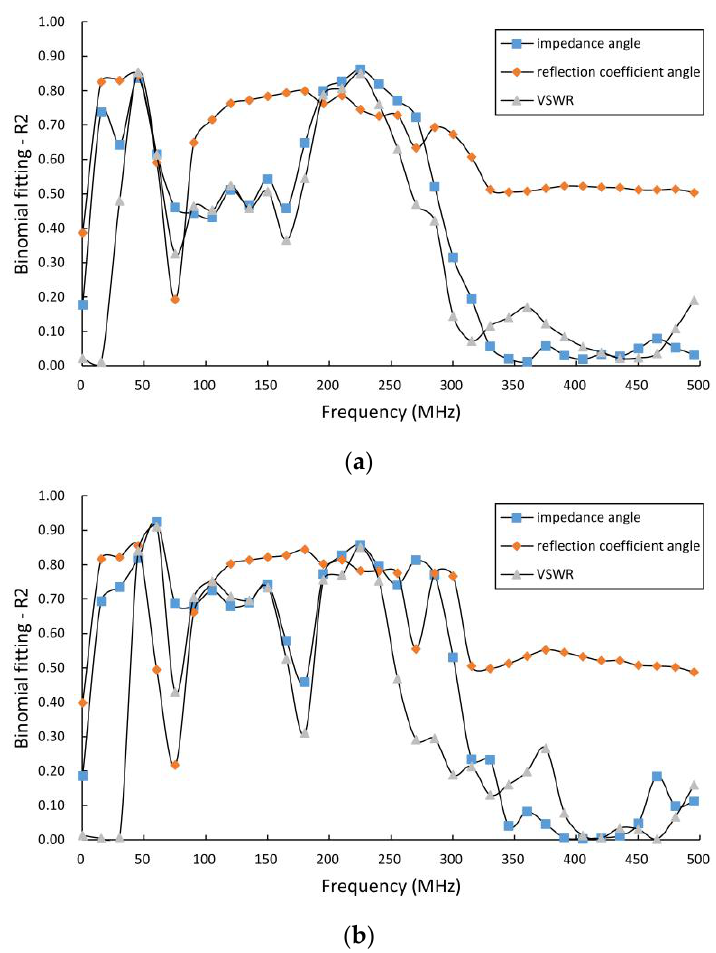
Figure 11. R 2 of the quadratic polynomial fitting over the sweep frequency range. ( a ) Corn: JINDAO111; and ( b ) corn: JH1303.